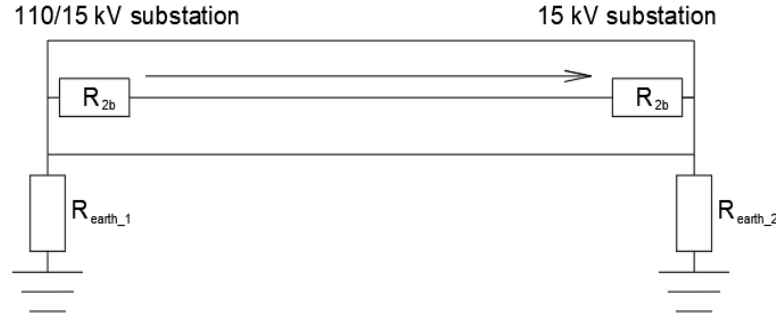
Figure 8. Measured cable screen current; sampling 0.25 s.